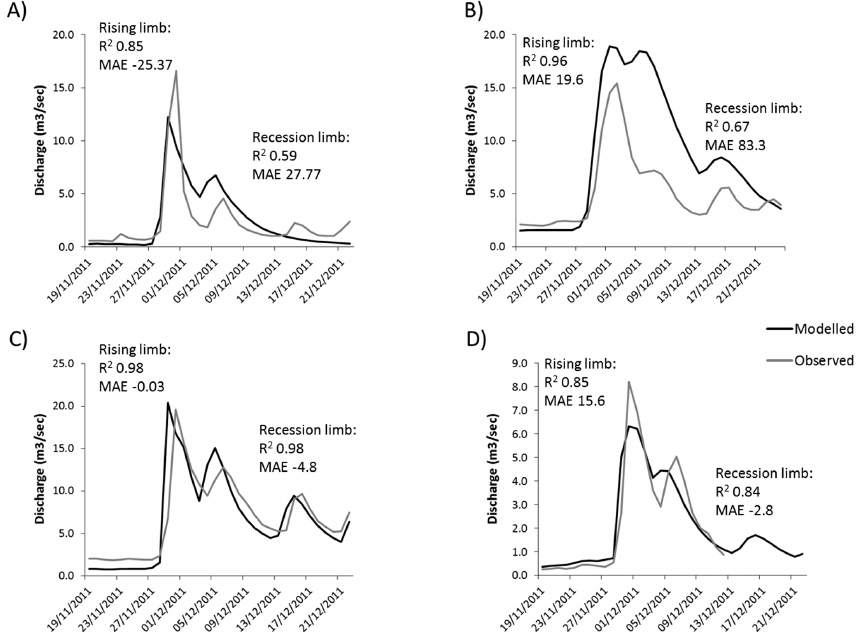
Figure 7. Analysis of INCA model fit to event data at outflow of (a) Holland, (b) Pefferlaw, (c) Beaver and (d) Whites catchments. Rising and recession limb at analysed separately for R 2 and model average error (MAE) to determine model performance under precipitation events. All events were analysed during the same four day period of intense precipitation in November 2011. Although event curves can be used to confirm model representation of reality, it should be noted they should not be used to compare response times between catchments.